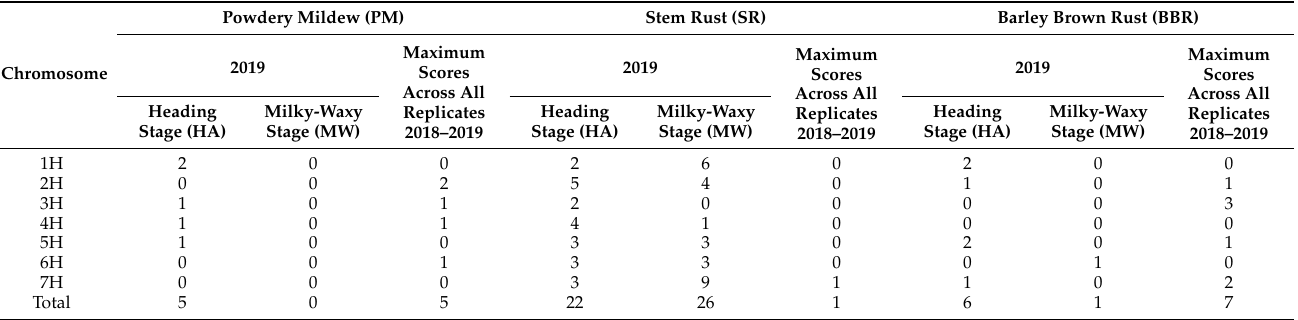
Table 2. Summary of the number of significant (false discovery rate adjusted to ≤ 0.05) marker–trait associations per chromosome per